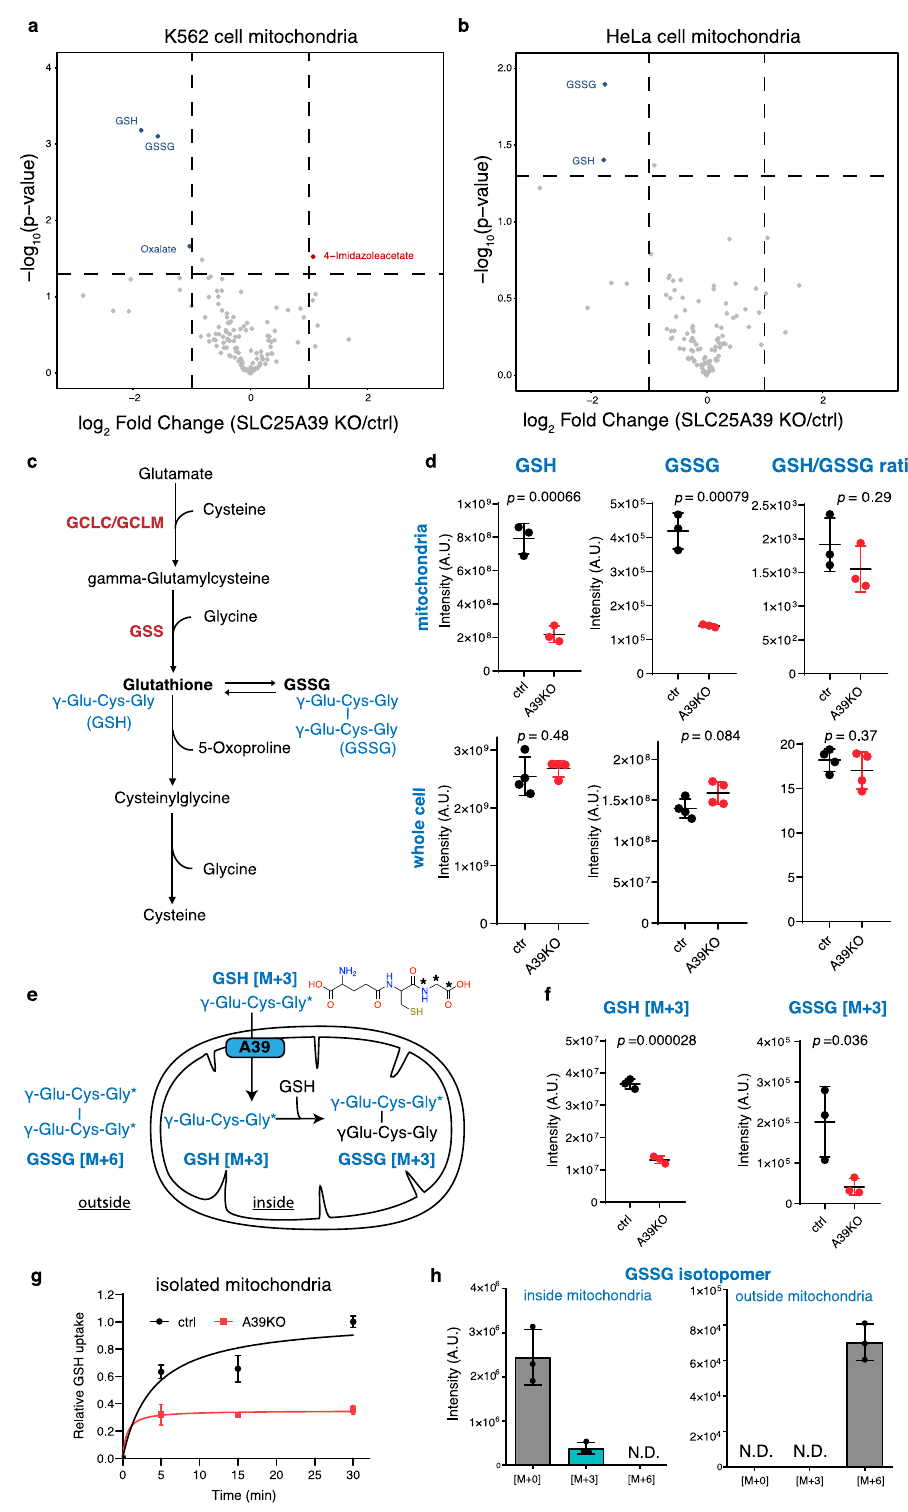
pro fi ling of the isolated mitochondria revealed a striking depletion of both the reduced and the oxidized glutathione, GSH and GSSG, in the A39 KO mitochondria compared to the controls (Fig. 4a, d, and Supplementary Data 6), a result that is also replicated using an independent guide RNA agaist A39 (Supplementary Fig. 4d). We could also validate this fi nding in the A39 KO Hela cells (Fig. 4b, Supplementary Fig. 4c,and